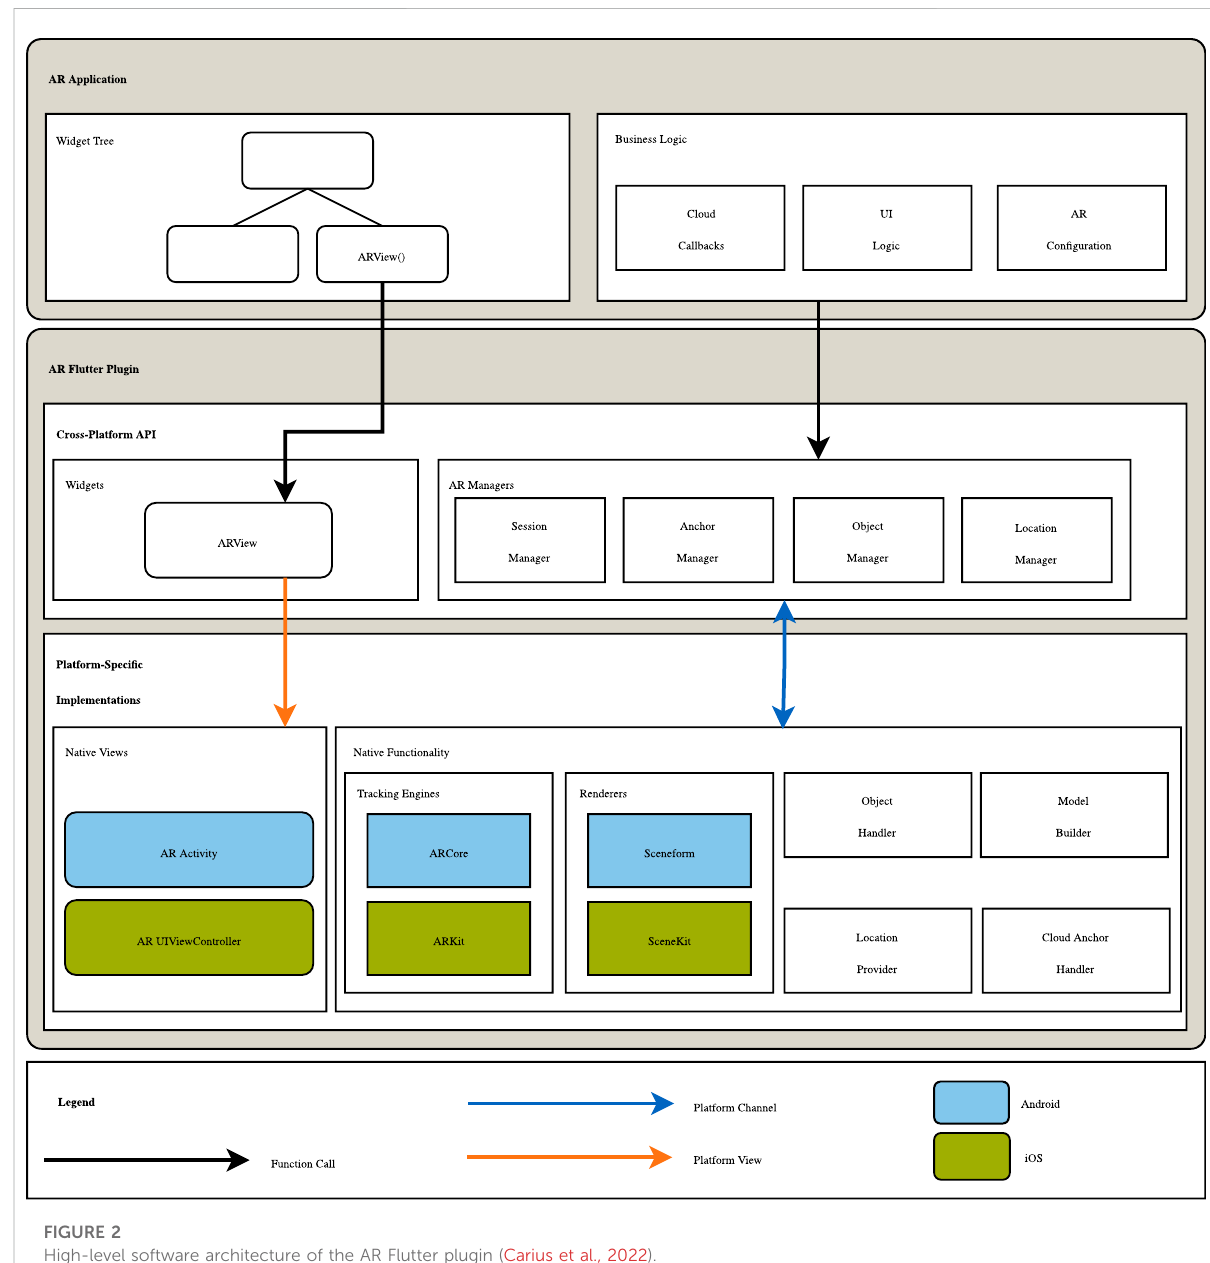
FIGURE 2 High-level software architecture of the AR Flutter plugin (Carius et al.,